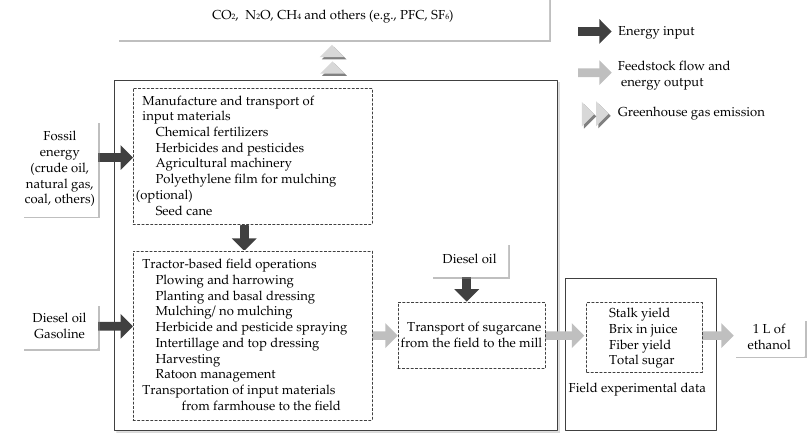
Figure 1. System boundary of sugarcane cultivation and transportation for bioethanol production in the study area.